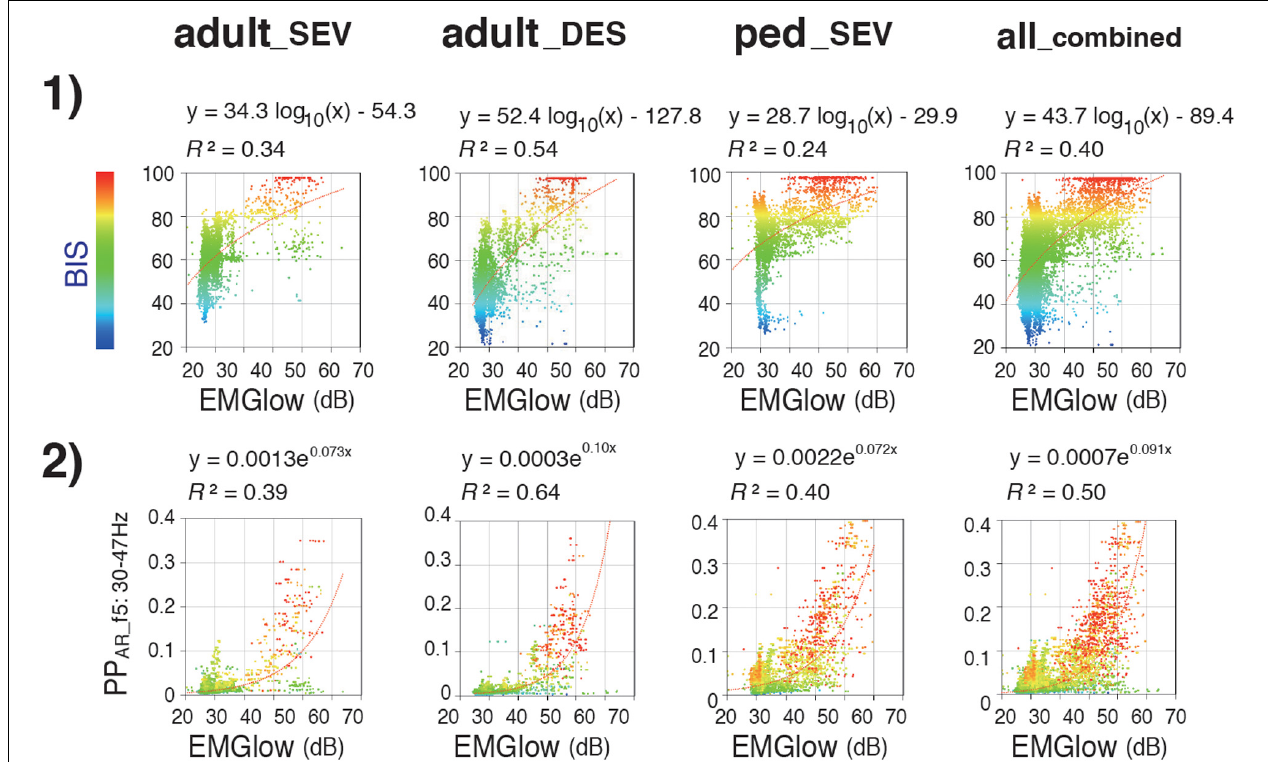
FIGURE 7 | Relationships of EMGlow with BIS and Poincaré plot parameter PP AR _ f 5 . Scatter plots display correlations between (1) EMGlow and BIS and (2) EMGlow and PP AR _ f 5 in the adult _ SEV , adult _ DES , and ped _ SEV groups and in the all _ combined group. adult _ SEV , adult patients anesthetized with sevoflurane ( n = 20); adult _ DES , adult patients anesthetized with desflurane ( n = 20); ped _ SEV , pediatric patients anesthetized with sevoflurane ( n = 20); all _ combined , all patients from the three groups ( n = 60). RINEARN Graph 3D (free software ver 5.6, https://www.rinearn.com, RINEARN, Kyoto, Japan) was used for the creation of graphs. EMGlow, a BIS monitor-derived electromyography parameter corresponding to absolute power in the 70–110 Hz range, and values in decibel (dB) with respect to 0.0001 µ V 2 ; BIS, bispectral index; PP AR _ f 5 , Poincaré plot-area ratio at f5:30–47 Hz; R 2 , coefficient of